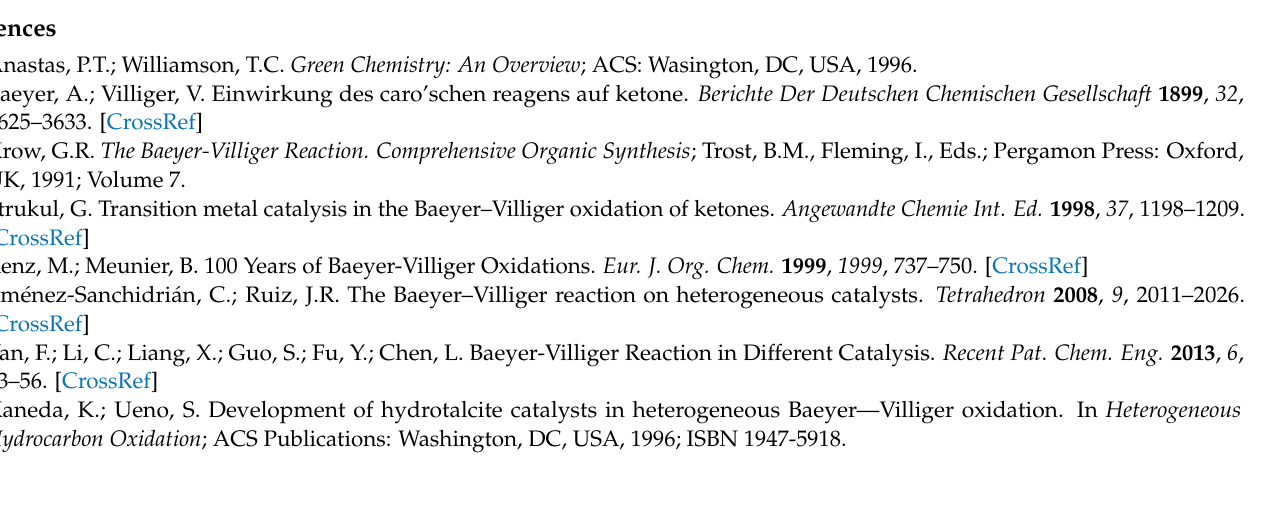
SiO 2 (dashed line). Figure S2: XRD patterns for synthetized solids: HT-2D (a); SiO 2 microspheres; (b) and SiO 2 @HT (c). Figure S3: µ -Raman spectra for synthetized solids: HT-2D (a); SiO 2 microspheres (b) and SiO 2 @HT (c). Figure S4: TEM images for synthetized solids: (a) HT-2D; (b) SiO 2 microspheres and (c) SiO 2 @HT. Figure S5: Nitrogen adsorption–desorption isotherm for (a) HT-2D and (b) SP-SiO 2